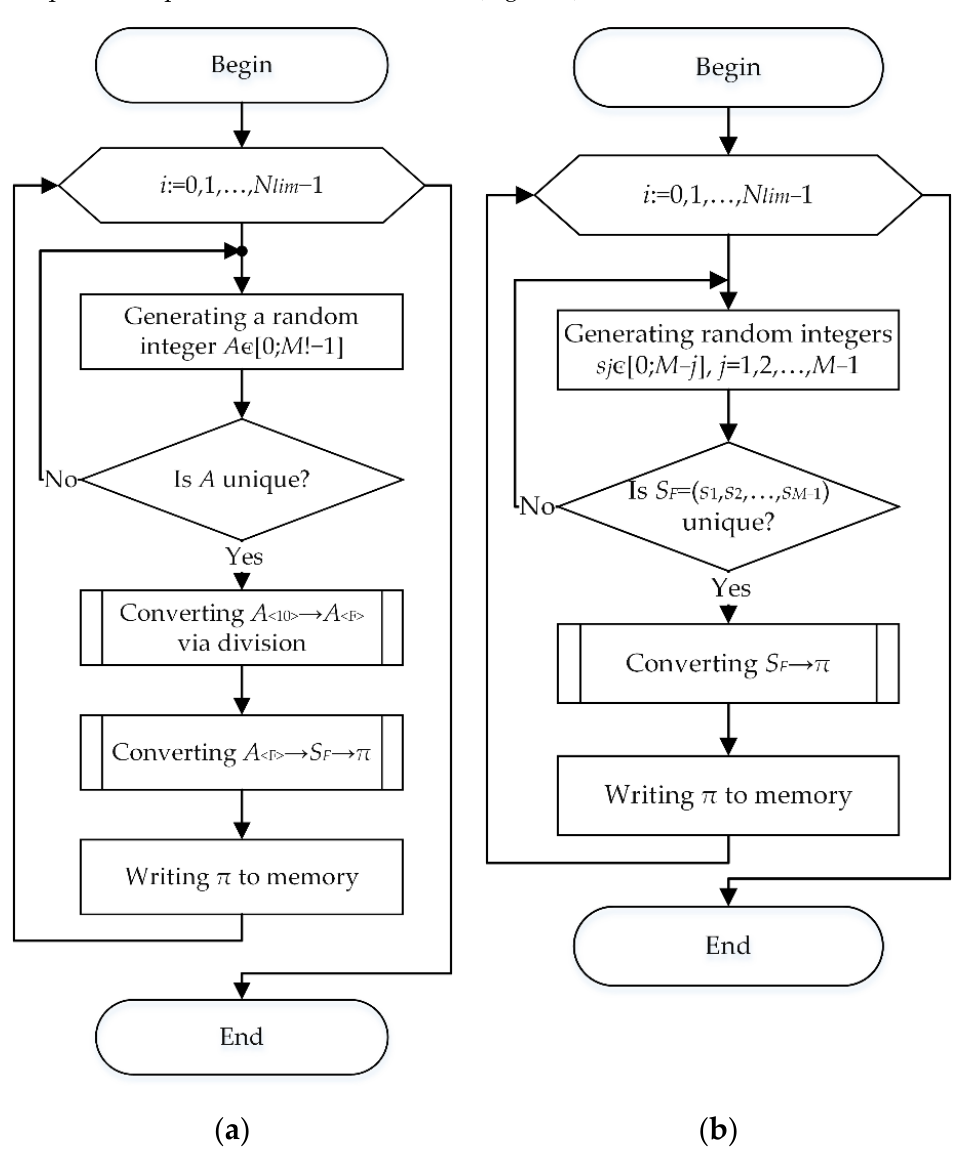
Figure 5. Algorithms to generate the initial set of N lim random permutations: ( a ) By division; ( b ) By generating digits.